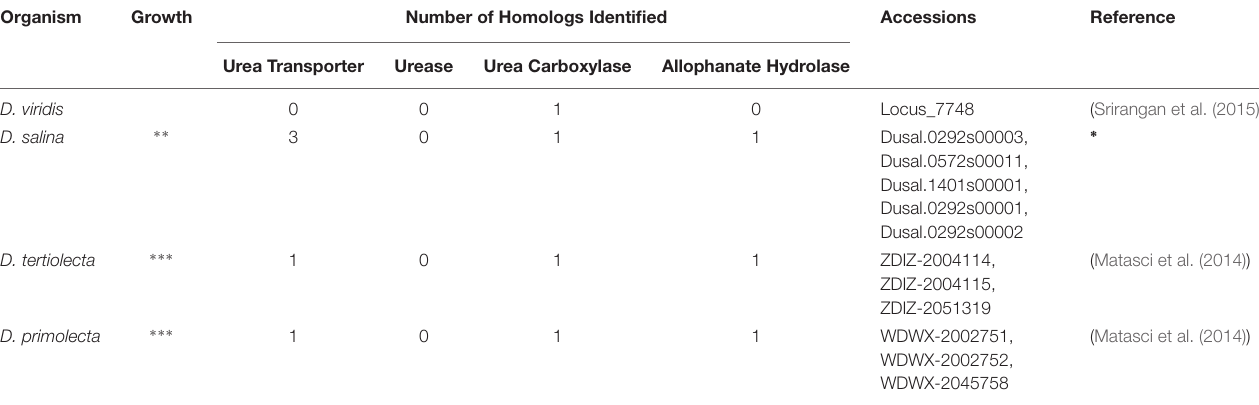
FIGURE 3 | Growth of Dunaliella spp. using NH 4 Cl as the sole nitrogen source. Total cell density of cultures grown for 144 h on mBA-N containing NH 4 Cl at varied concentrations (in mM). Average cell density was measured from four biological replicates. Error bars represent one standard deviation. Significant growth relative to the un-supplemented mBA -N control was assessed using a two-tailed paired Student’s t -Test at p ≤ 0.05 ( ∗ ), p ≤ 0.01 ( ∗∗ ), and p ≤ 0.001 ( ∗∗∗ ). Four biological replicates were used for analysis. TABLE 1 | Variation in the ability of Dunaliella spp. to use urea as a nitrogen source. Organism Growth Number of Homologs Identified Accessions